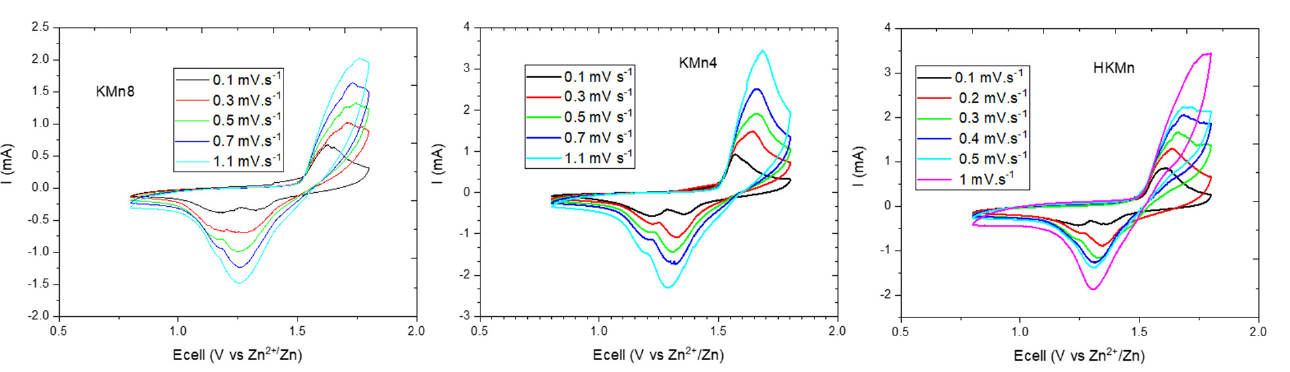
Figure 6. Cyclic voltammetry curves for KMn8, KMn4, and